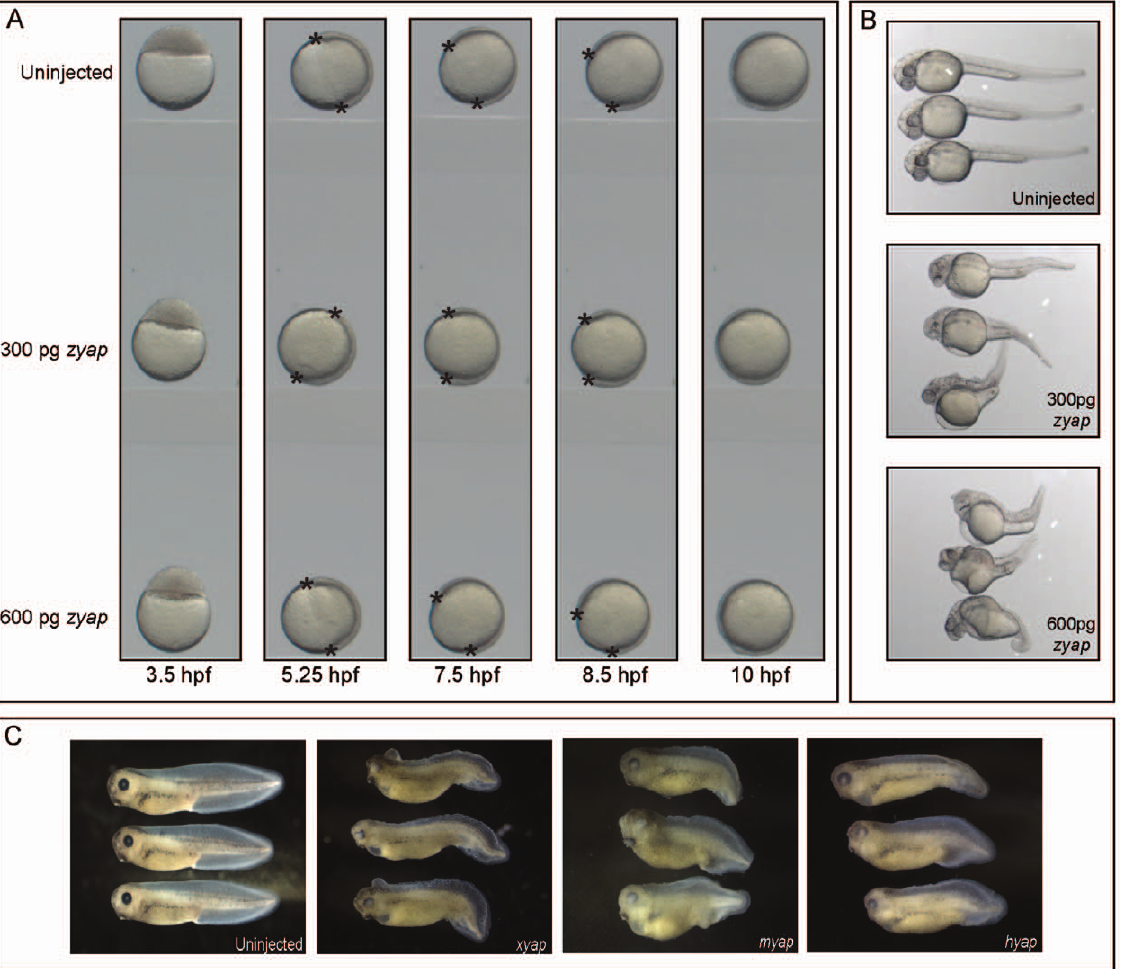
Figure 3. zYAP and xYAP gain-of-function results in similar body axis defects. ( A ) Time-lapse videomicroscopy shows that zYAP gain-of- function does not alter the timing of gastrulation movements, as evidenced by the progression of epiboly (asterisks mark the fronts of tissue movement around the yolk). ( B ) zYAP gain-of-function in Danio rerio embryos resulted in head and eye deformities and shortened, malformed body axes. Examples of two different mRNA doses are shown. ( C ) Injection of Xenopus (x), mouse (m), or human (h) yap mRNAs into Xenopus embryos all showed phenotypes similar to those in zebrafish.